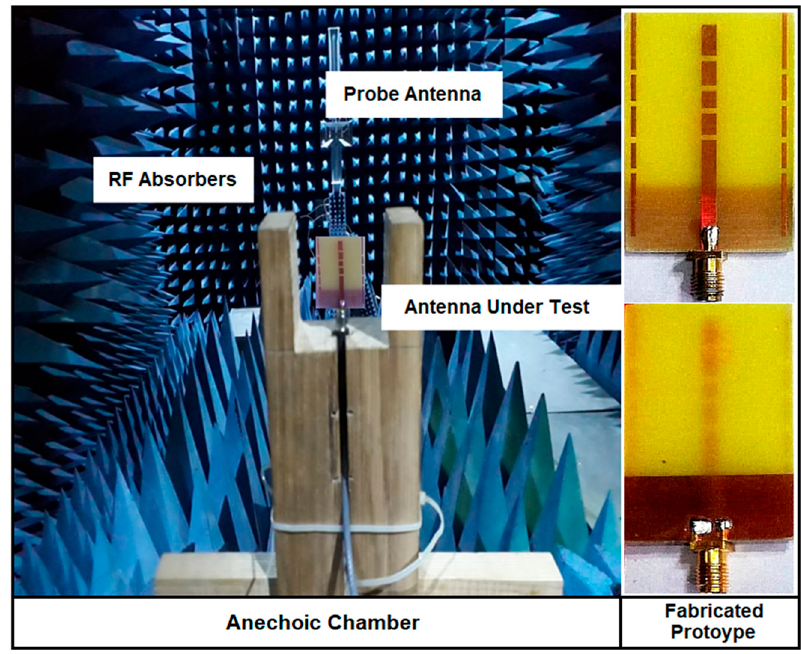
Figure 6. Experimental setup for measurement of radiation patterns.